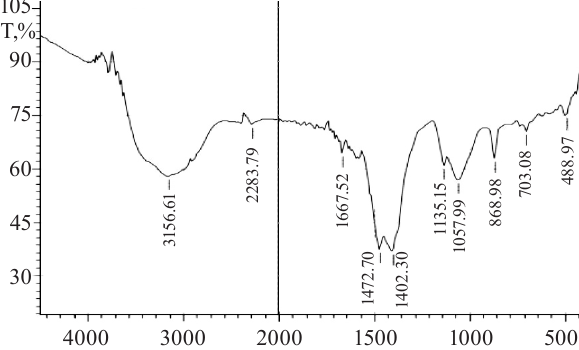
Figure 7 Infrared spectra of activated